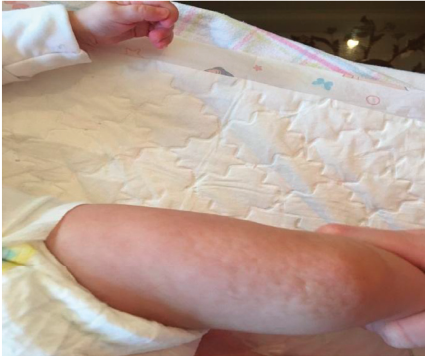
Figure 6: Disappearance of skin lesions in 11-month